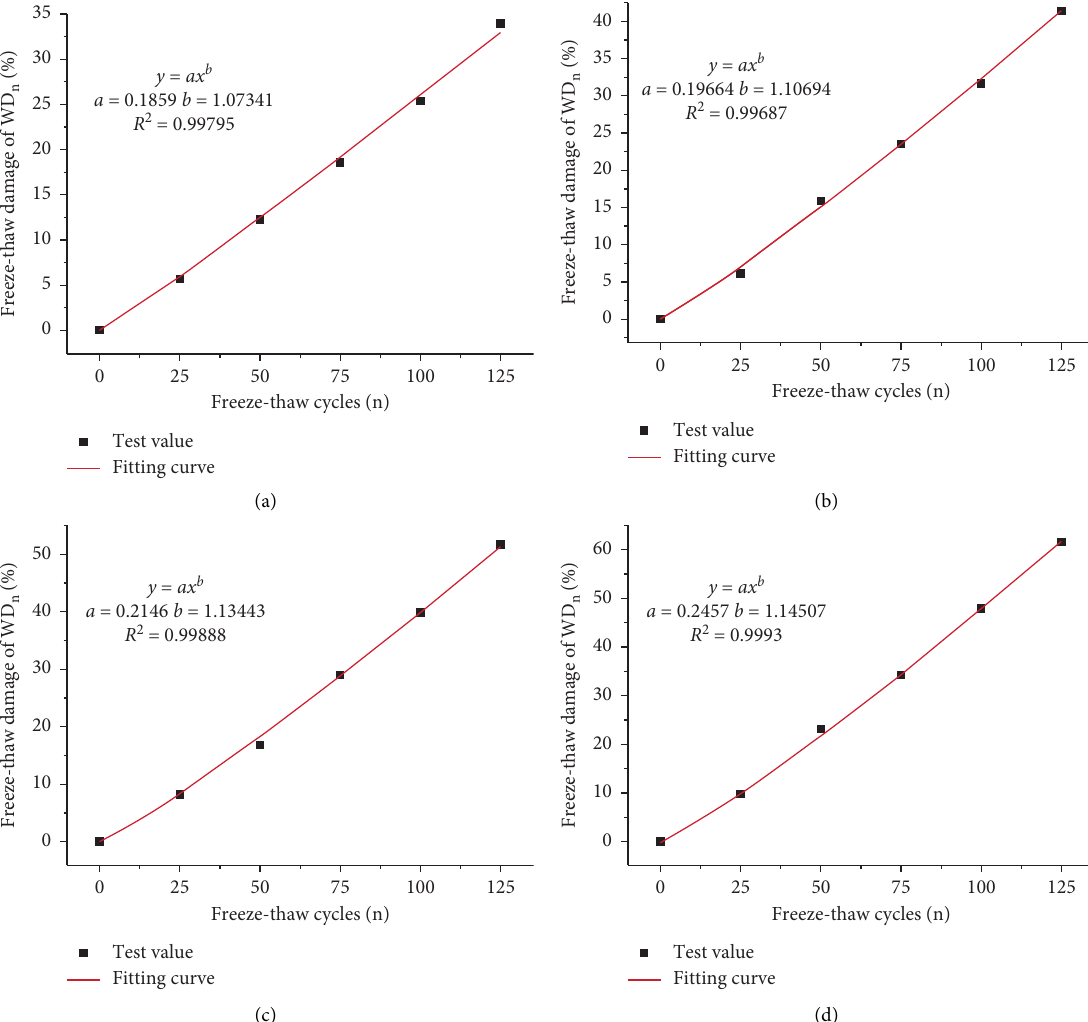
Figure 11: Freeze-thaw damage of fracture energy of coal gangue concrete under different replacement rates. (a) Replacement rate of 0%. (b) Replacement rate of 40%. (c) Replacement rate of 70%. (d) Replacement rate of